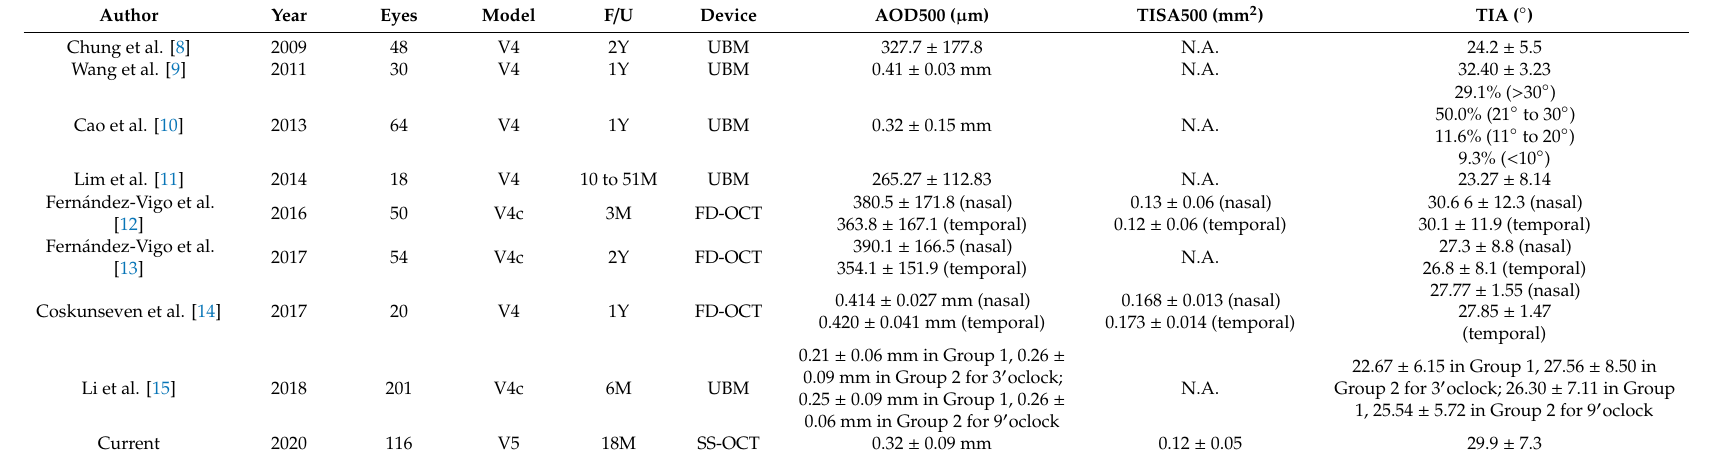
Table 3. Previous studies reporting angle opening metrics in eyes undergoing implantable collamer lens